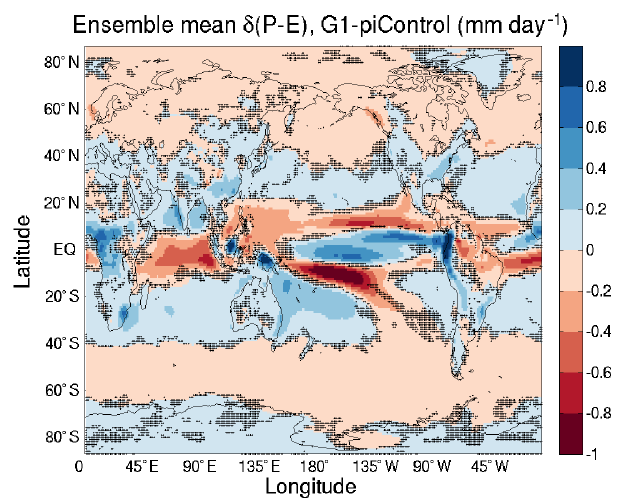
Figure 2. The annual mean distribution of precipitation minus evap- oration rate anomalies (mmyear − 1 ) between G1 (years 11–50) and piControl (all years) averaged among 11 models (EC-Earth ex- cluded due to unphysical result). The stippling indicates where fewer than 64% of the models agree on the sign of the change. These results appear in Kravitz et al.